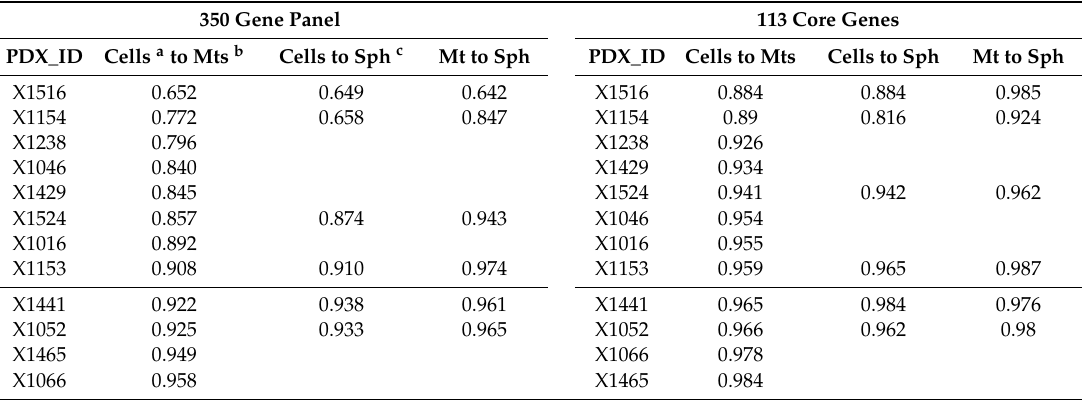
Table 3. Pairwise Pearson correlation coe ffi cients between